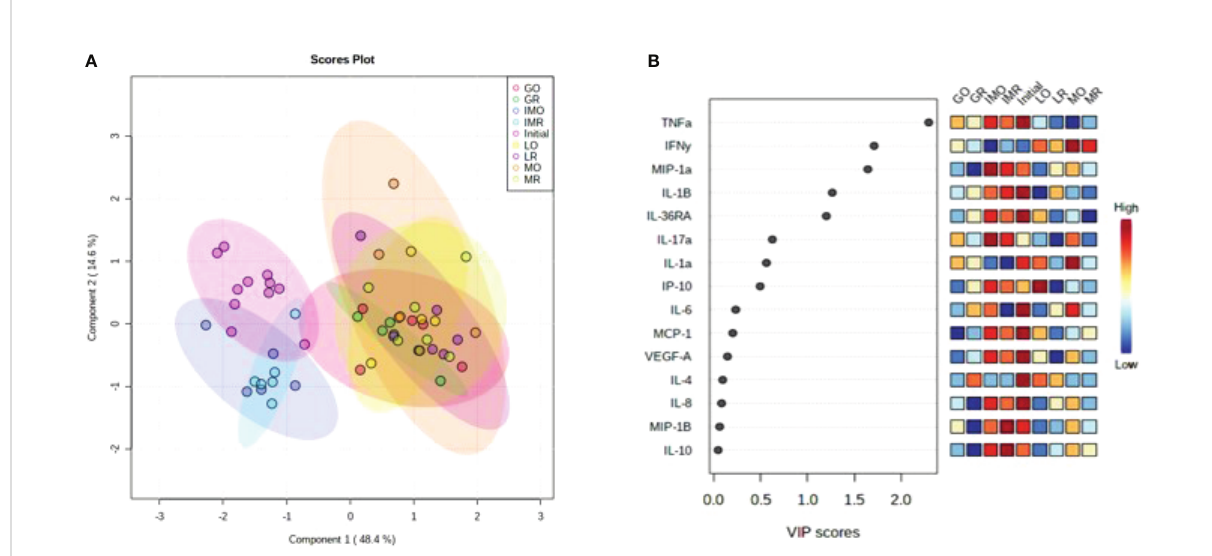
FIGURE 3 Analysis of cytokine pro fi les based on nutritional treaments: (A) Partial least squares discriminant analysis visualizing differences in in fl ammatory cytokines during differing nutritional treatments and (B) Variable importance in the projection for individual cytokines plot. A single ellipse represents a 95% con fi dence interval within that nutritional